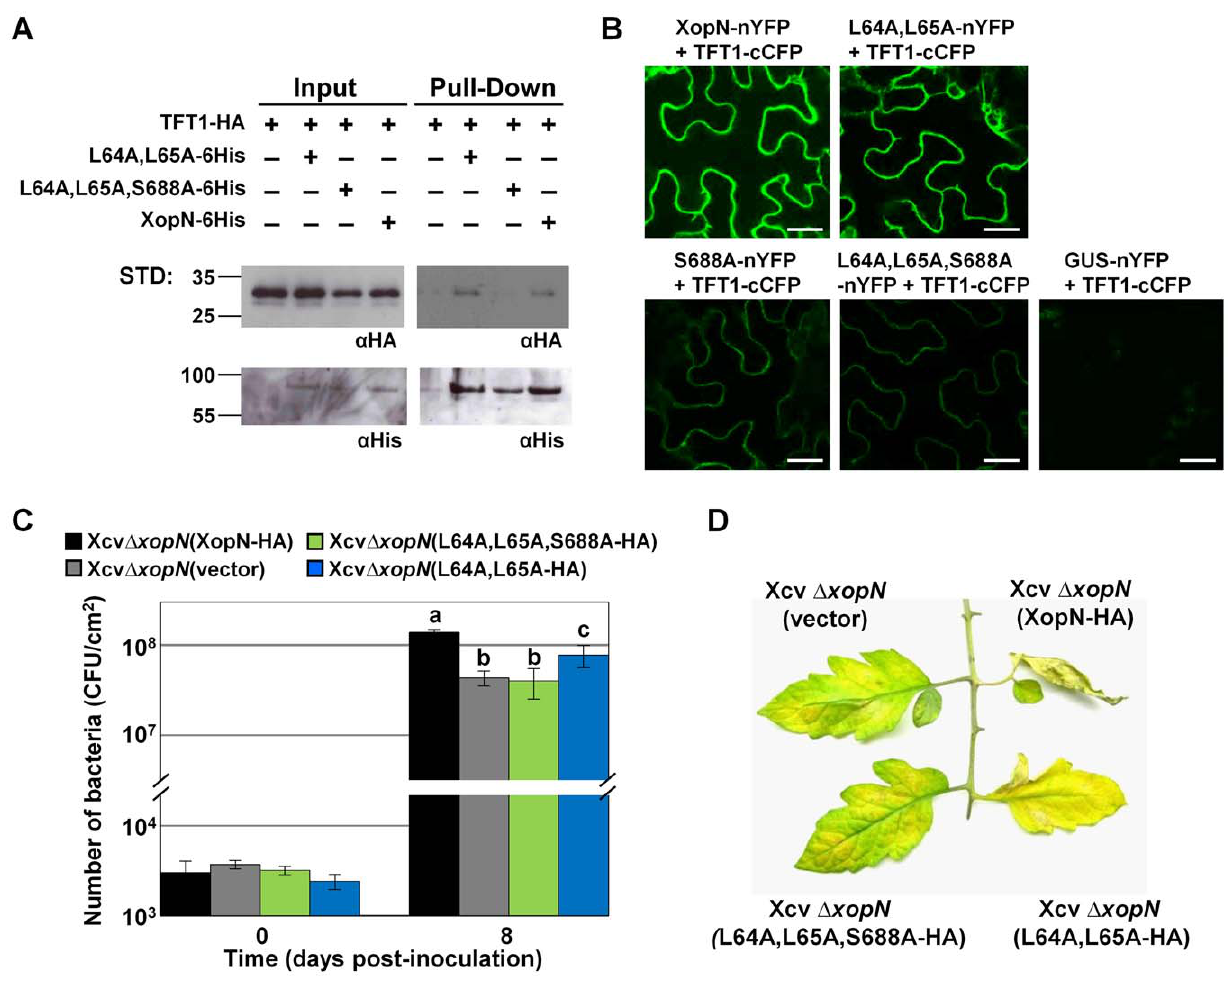
Figure 8. XopN L64,L65 motif and S688 are required for TFT1 binding and XopN-dependent virulence. ( A ) Pull-down analysis of TFT1- HA and XopN(L64A,L65A,S688A)-6His, XopN(L64A,L65A)-6His, or XopN-6His in N. benthamiana . Leaves were infiltrated with a mixed suspension of A. tumefaciens expressing TFT1-HA (4 6 10 8 CFU/mL) and A. tumefaciens expressing XopN(L64A,L65A)-6His, XopN(L64A,L65A,S688A)-6His or XopN-6His (4 6 10 8 CFU/mL). After 48 h, protein was extracted, purified by Ni + affinity chromatography, and then analyzed by protein gel blot analysis using anti- His and anti-HA sera. Expected protein MW: TFT1-HA=29.3 kDa; XopN(L64A,L65A)-6His, XopN(L64A,L65A,S688A)-6His and XopN-6His=78.7 kDa. + , protein expressed; 2 , vector control. STD, molecular weight standard. ( B ) BiFC analysis of XopN/TFT1 interactions in N. benthamiana . Leaves were hand-infiltrated with a suspension (8 6 10 8 CFU/mL total) of two A. tumefaciens strains expressing different fusion proteins (XopN-nYFP + TFT1-cCFP; L64A,L65A-nYFP + TFT1-cCFP; S688A-nYFP + TFT1-cCFP; L64A,L65A,S688A-nYFP + TFT1-cCFP; or GUS-nYFP + TFT1-cCFP) and then visualized by confocal microscopy at 48 HPI at 63X. White bar=25 m m. ( C ) Growth of Xcv D xopN (vector), Xcv D xopN (L64A,L65A,S688A-HA), Xcv D xopN (L64A,L65A-HA), or Xcv D xopN (XopN-HA) strains in susceptible VF36 tomato leaves. Leaves were hand-infiltrated with a 1 6 10 5 CFU/mL suspension of bacteria. Number of bacteria in each leaf was quantified at 0 and 8 DPI. Data points represent mean CFU/cm 2 6 SD of three plants. Different letters at day 8 indicate statistically significant (one-way analysis of variance and Tukey’s HSD test, P , 0.05) differences between the samples. Vector=pVSP61. Analysis was repeated at least three times. ( D ) Phenotype of tomato leaves inoculated with the strains described in ( C ). Leaves were photographed at 12 DPI. Similar phenotypes were observed in 3 independent